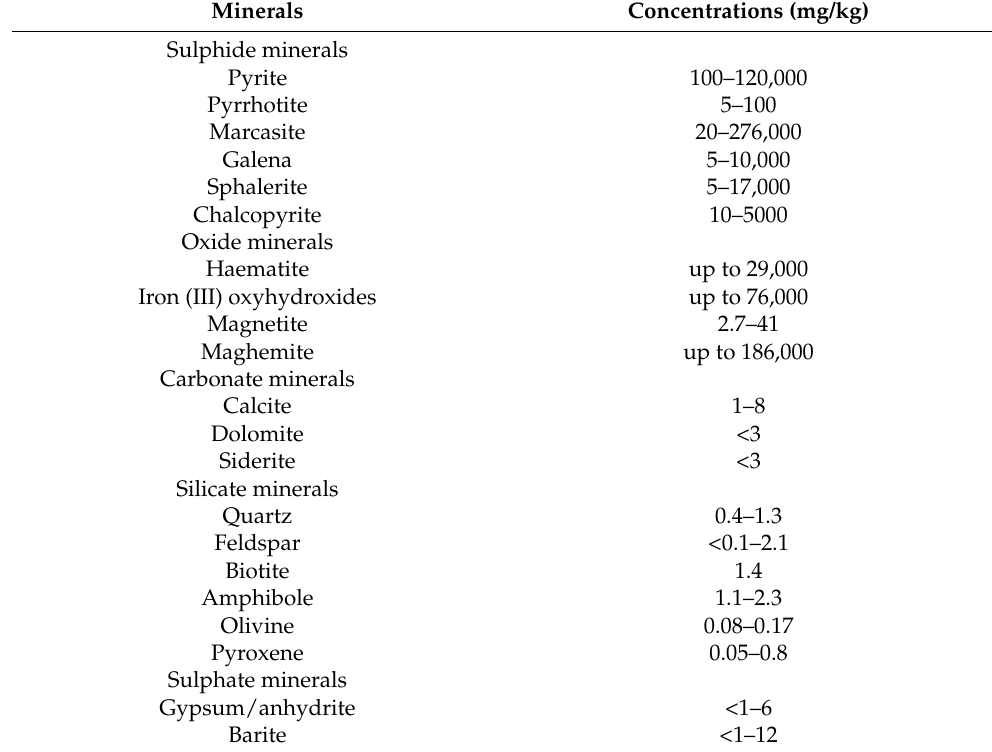
Table 6. Concentration of As in minerals